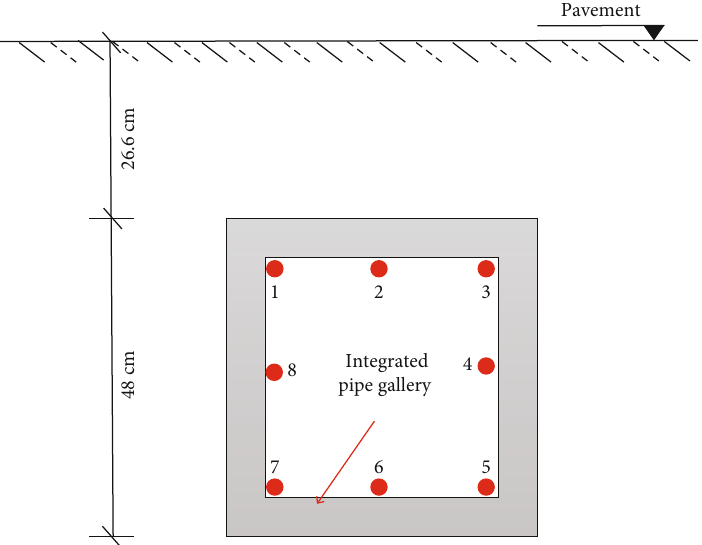
Figure 4: Layout of the transverse section of stress measuring